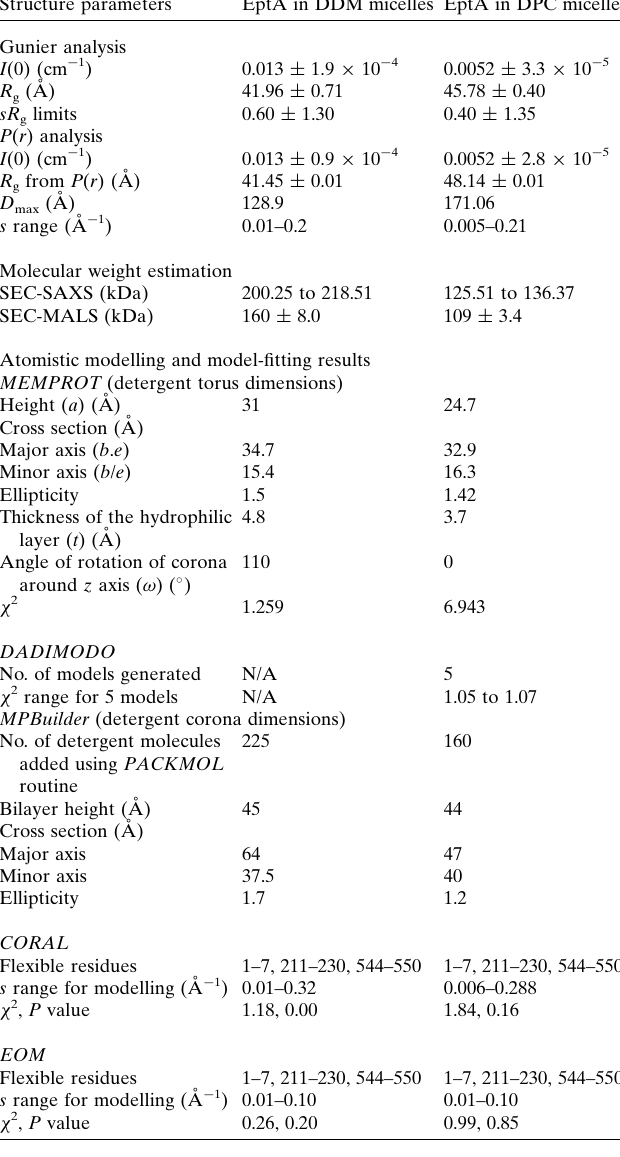
Table 1 Statistics for the small-angle X-ray scattering data analysis and modelling of EptA in different detergent micelles. Structure